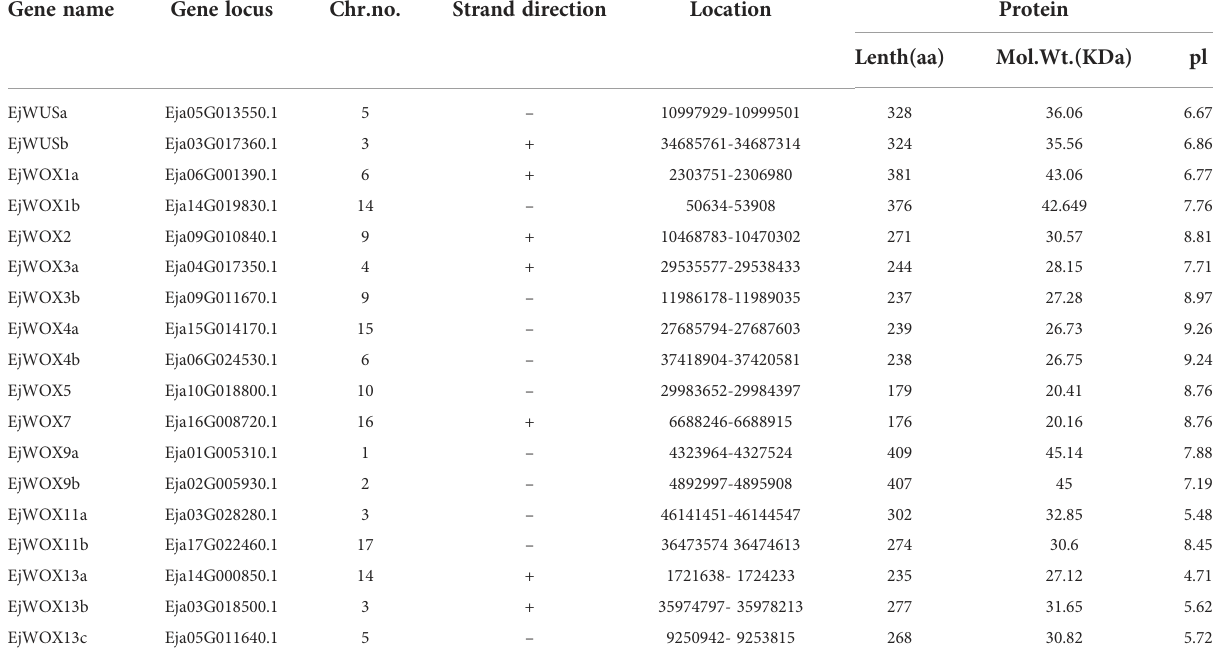
TABLE 1 The characteristics of EjWOX genes in